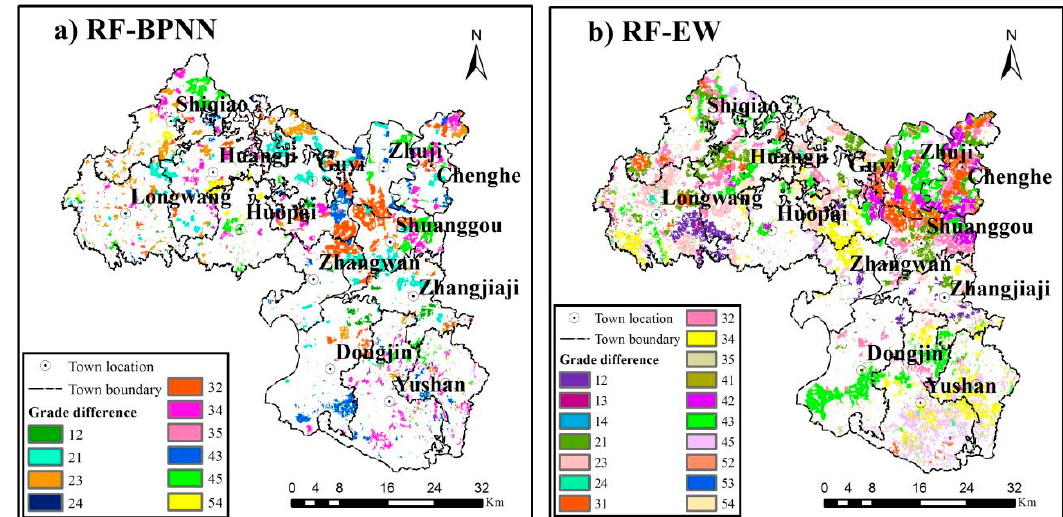
Figure 9. Spatial distribution of farmland quality grade differences between ( a ) RF and BPNN and ( b ) RF and EW.